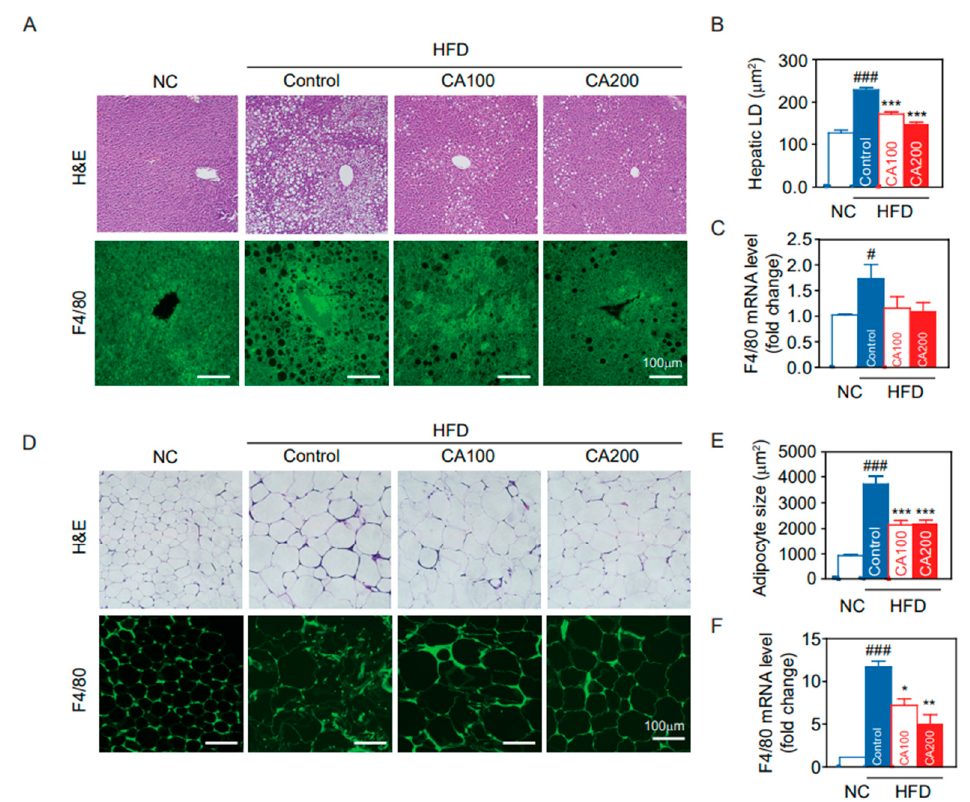
Figure 5. Histological analysis of the liver and epididymal fat pad (EWAT). ( A ) liver H&E staining and F4/80 immunostaining, ( B ) hepatic lipid droplet (LD) area, ( C ) F4/80 mRNA levels in the liver, ( D ) EWAT H&E staining and F4/80 immunostaining, ( E ) adipocyte size of the EWAT, and ( F ) F4/80 mRNA levels in the EWAT. Data are expressed as the mean ± SEM ( n = 5). # p < 0.05, ### p < 0.001 vs. NC, and * p < 0.05, ** p < 0.01, and *** p < 0.001 vs. HFD-control. NC, normal chow; Control, HFD-control; CA100, HFD plus CA 100 mg/kg; CA200, HFD plus CA 200 mg/kg.